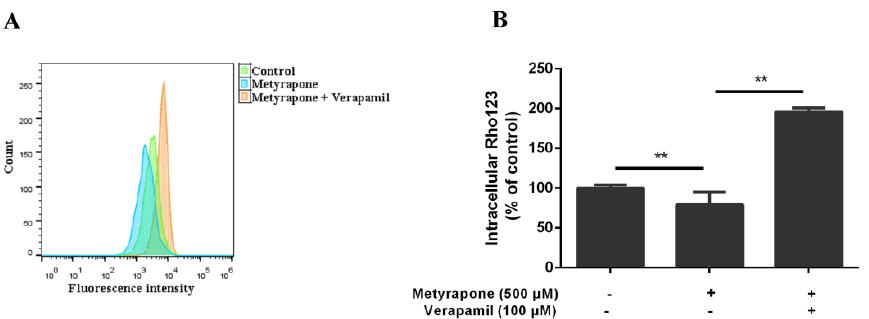
Figure 3. P-gp transport activity in chicken primary hepatocytes exposed to the CXR activator metyrapone. Intracellular Rho123 fluorescence was assessed in untreated cells and cells treated with 500 µ M metyrapone for 24 h with or without pre-exposure to the P-gp-specific inhibitor verapamil (100 µ M) for 1 h. ( A )The histogram shows fluorescence (x axis) representing Rho123 accumulation plotted as a function of the number of cells (y axis). ( B ) Summaries of Rho123 accumulation. Bars show means ± SD of at least three independent experiments. * p < 0.05; ** p < 0.01.